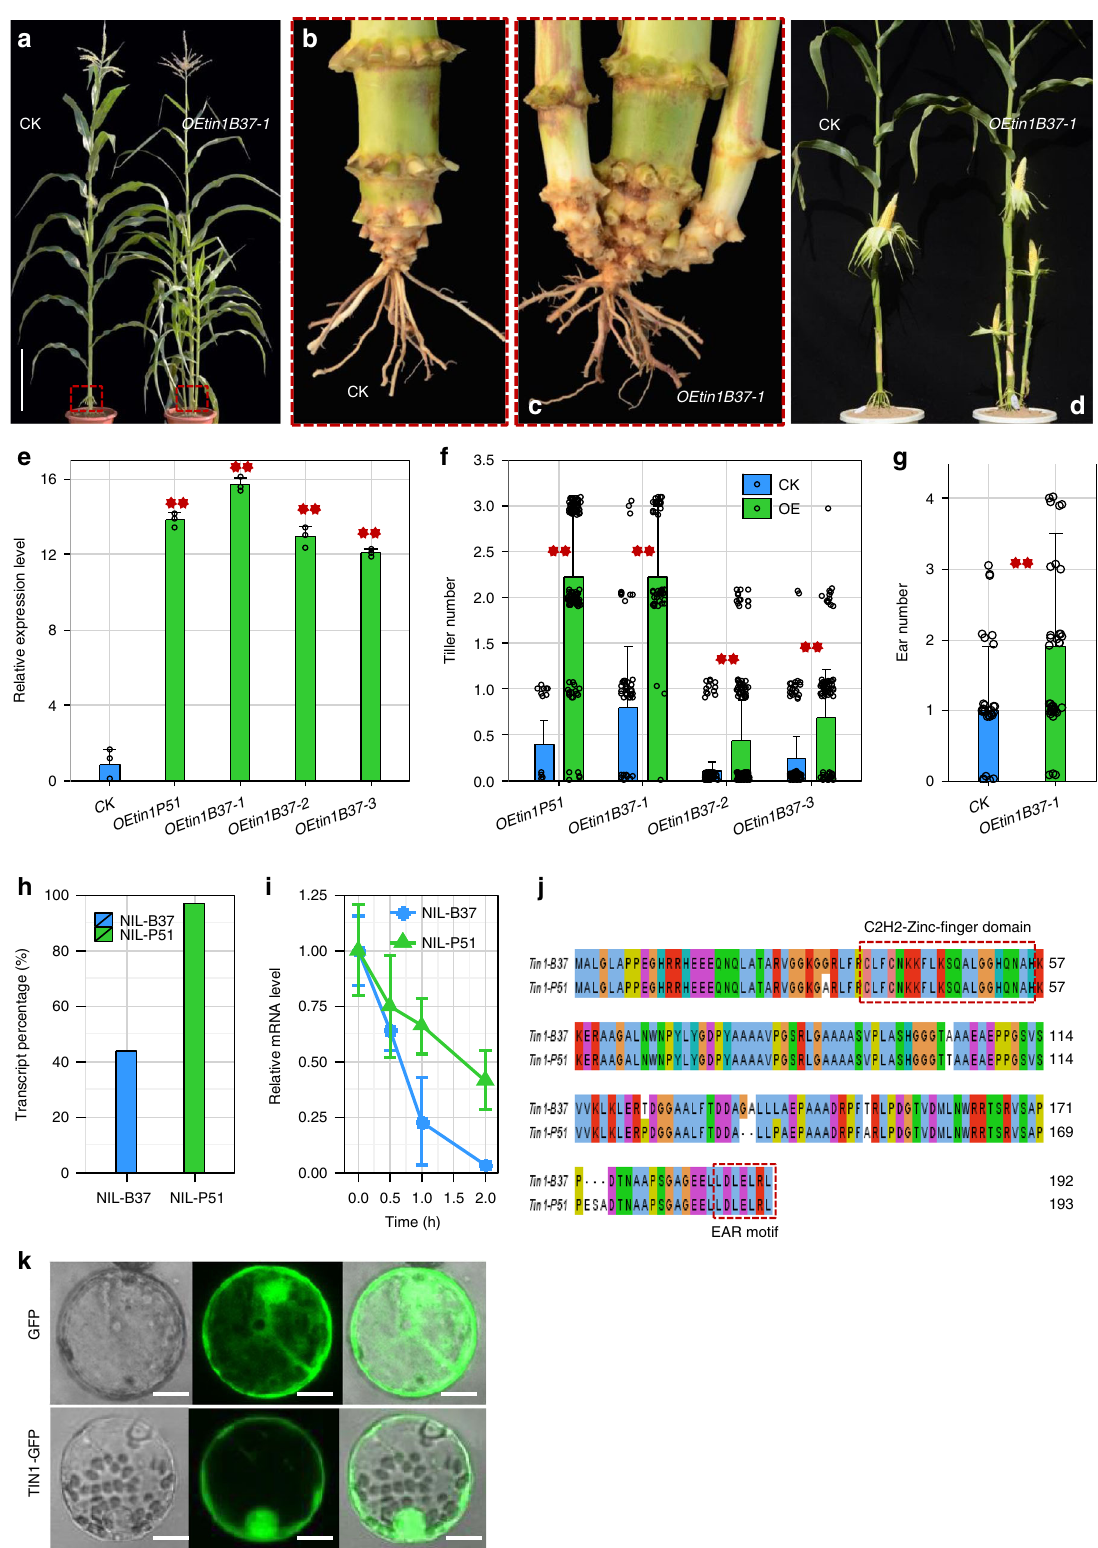
spliced transcripts ( tin1-T1 and tin1-T2 ) present in both B37 and P51 (Fig. 3d). The tin1-T1 transcript contained an unspliced intron (Supplementary Fig. 5). By contrast, the tin1-T2 transcript did not have this intron (Supplementary Fig. 5). The percentage of unspliced tin1-T1 transcript was 96.7% and 46.8% of the total